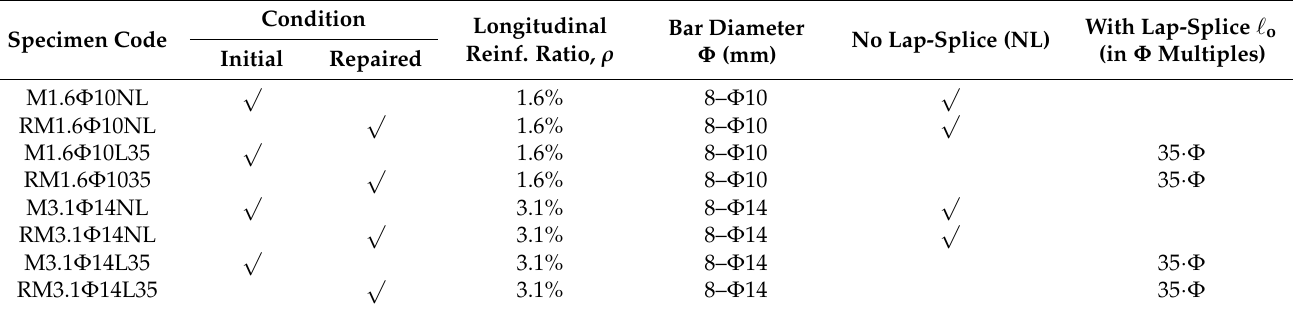
Table 1. Specimen parameters’ identification